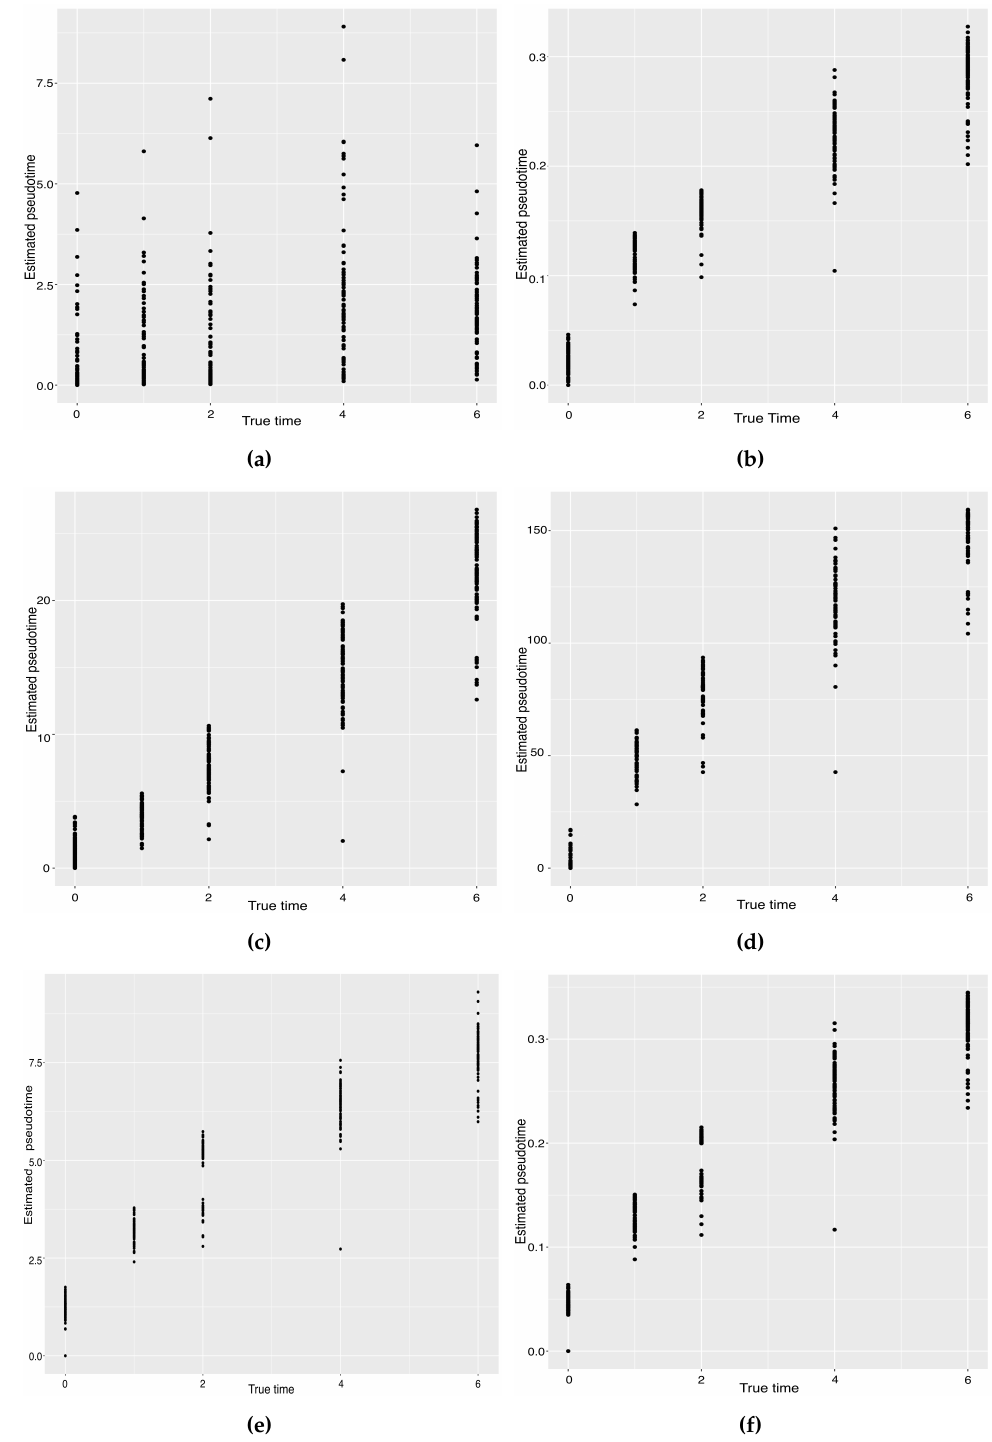
Figure 5. Scatter plots between the estimated pseudotimes and the true times for our approach and four existing TR methods on the mouse ES cell dataset. ( a ) SLICER. ( b ) Slingshot. ( c ) Monocle ICA. ( d ) Monocle DDRTree. ( e ) Linear Tree. ( f ) Curved